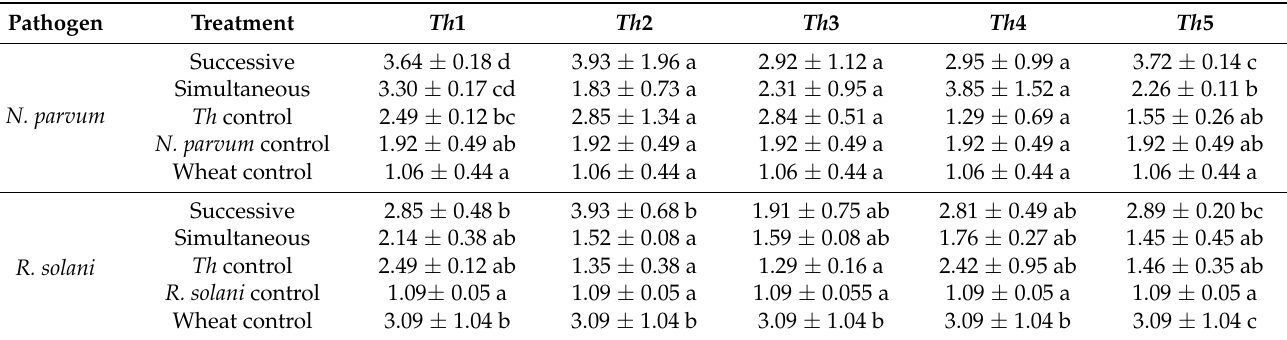
Table 3. Total dry weight of seedlings in grams (mean ± standard deviation) for each type of treatment (successive, simultaneous, and controls with T. harzianum , N. parvum , R. solani , and uninoculated wheat) obtained for each T. harzianum